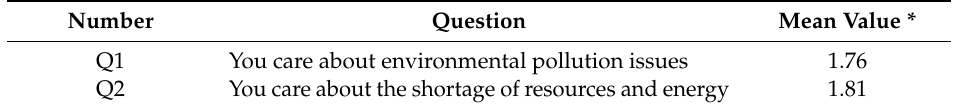
Table 3. The mean value of public awareness (PAW) of the environmental issues.